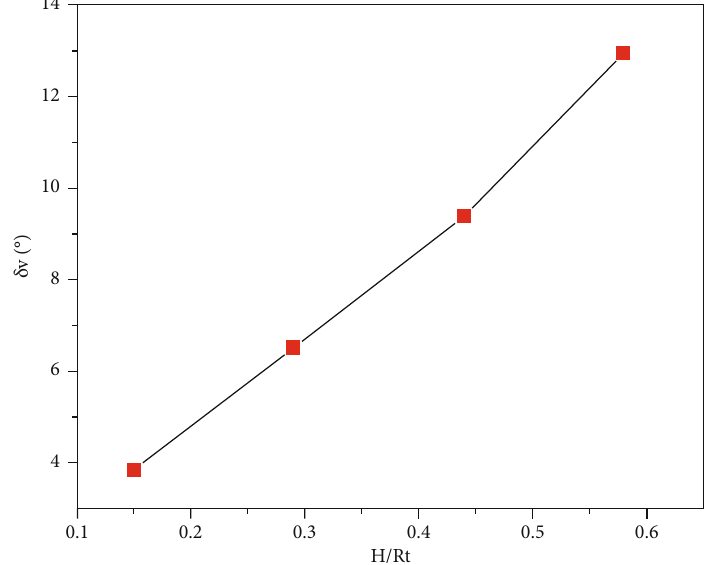
Figure 11: Vectoring angles for diverse rod penetration heights ( NPR = 4 : 6 and X normalized static pressures on top and bottom walls is obtained. Synchronously, a qualitative comparison of the experimental shadowgraph captured by a high-speed camera with the density gradient contour is illustrated in Figure 6.